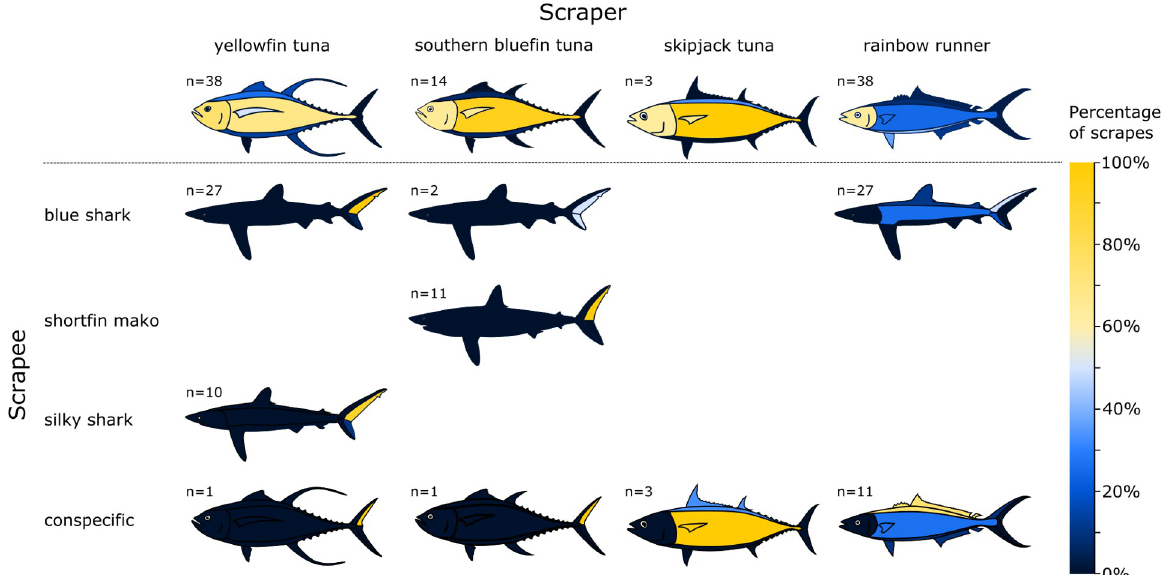
Fig 4. Most frequently scraped areas organised by scraper (vertical) and scrapee (horizontal) species. The upper panel shows the distribution of scraping areas on the scraper’s body with areas scraped at high proportions yellow and low proportions dark blue. The lower panel shows the areas on scrapees scraped by each scraper species again with areas contacted in higher proportions in yellow and lower proportions in blue. Number of interactions for each scraper-scrapee pair are